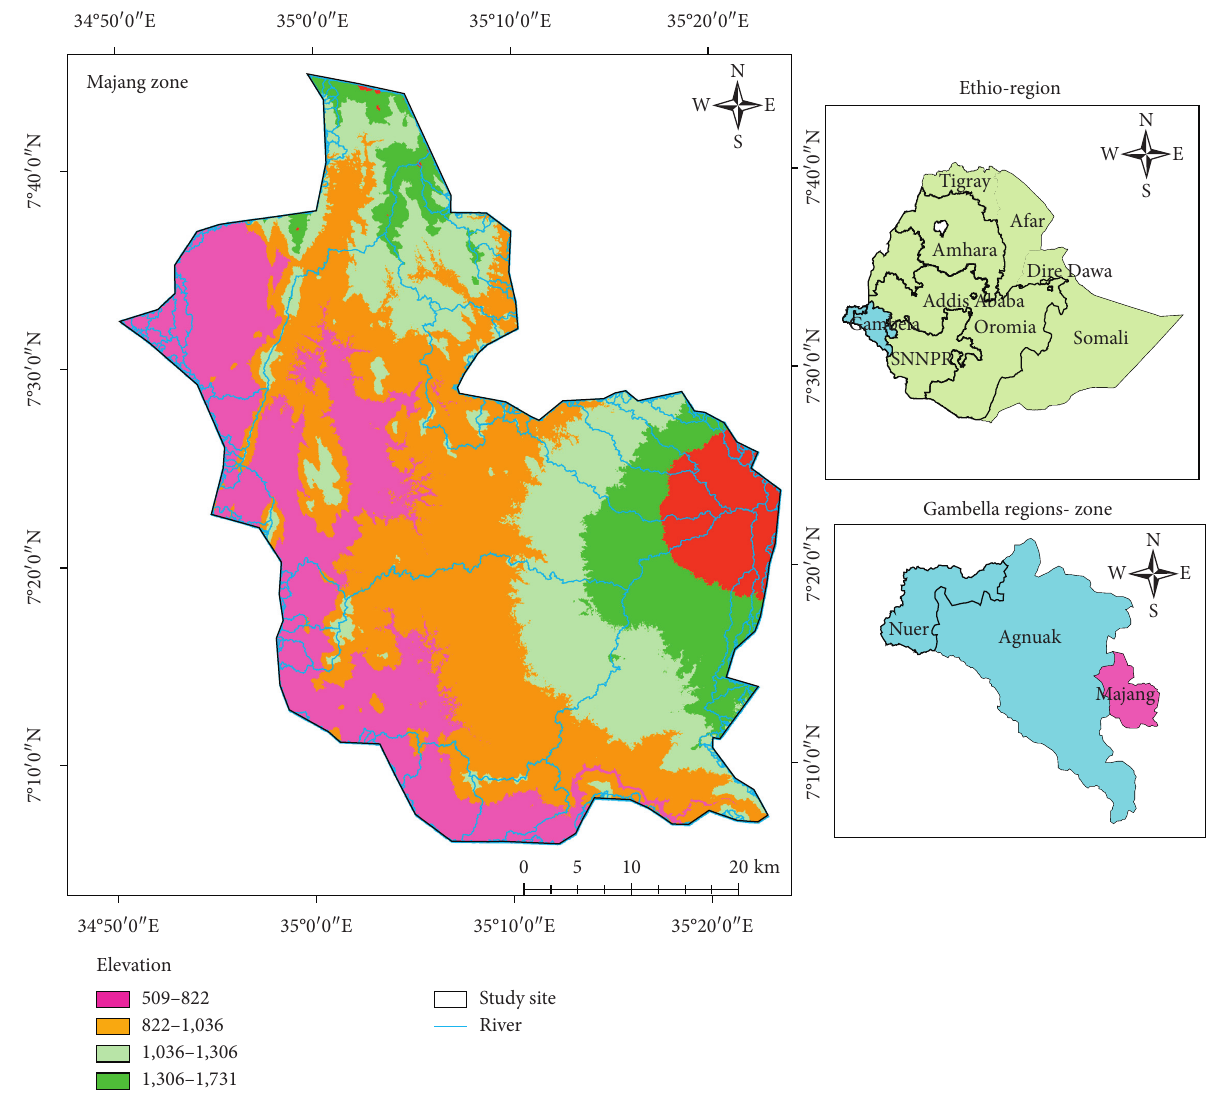
Figure 1: Location of the study